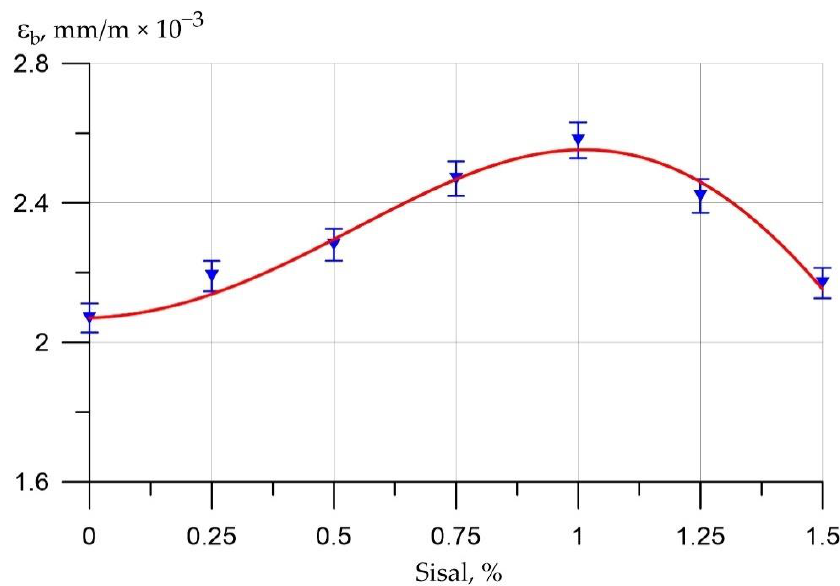
 of test concrete b